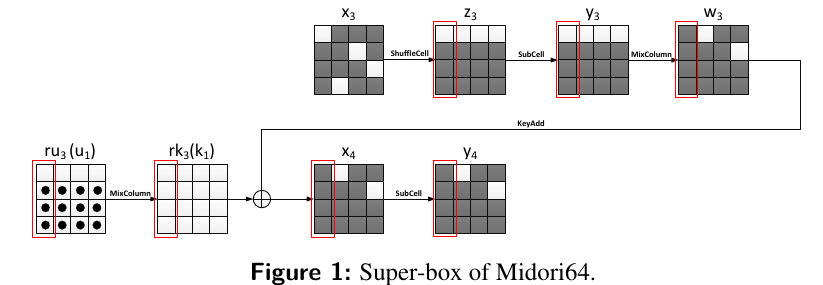
Figure 1: Super-box of